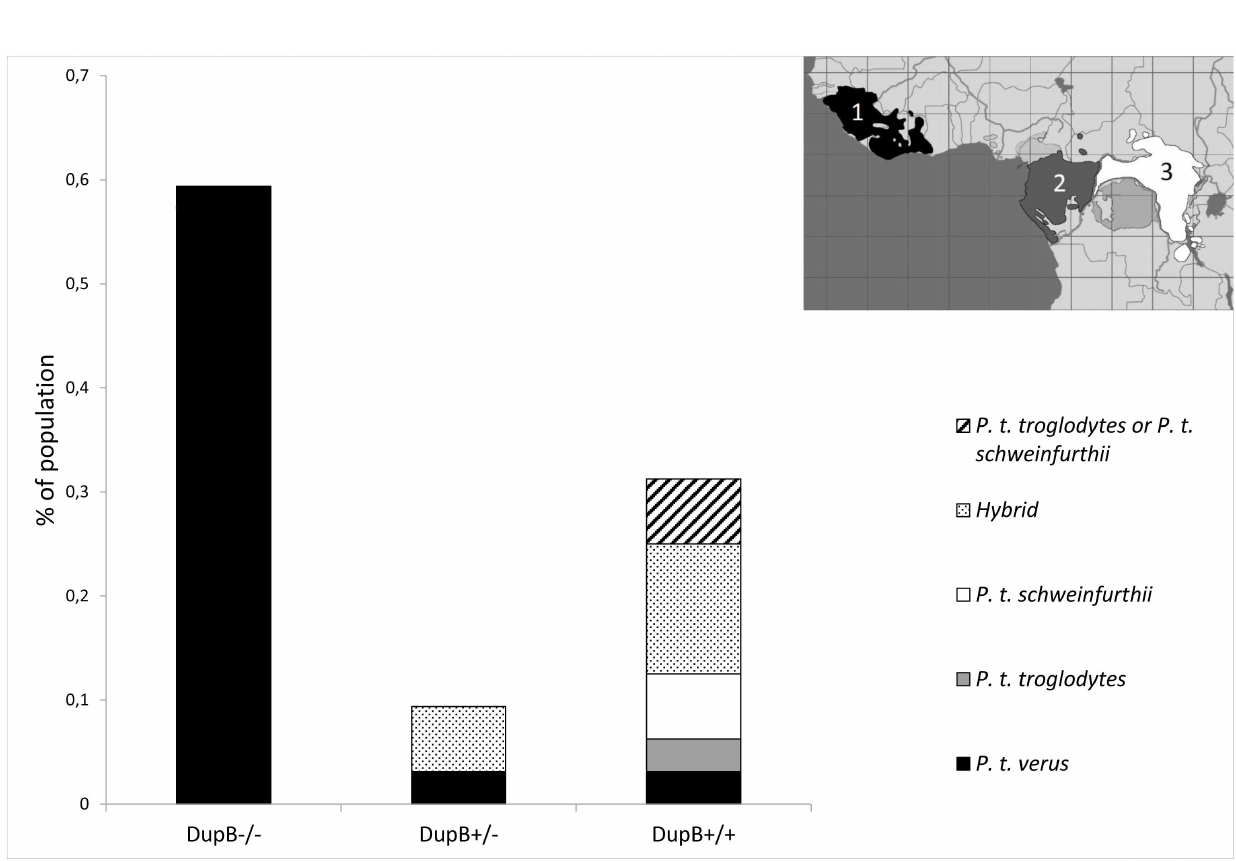
Figure 2. Distribution of DupB genotype frequencies for chimpanzee subspecies . X-axis shows individuals homozygous for the deletion (DupB 2 / 2 ), heterozygous for the deletion (DupB + / 2 ) or homozygous for the presence of RS3 (DupB + / + ). Different chimpanzee subspecies are indicated on the map in black (1) ( Pan troglodytes verus ), dark grey (2) ( Pan troglodytes troglodytes ) and white (3) ( Pan troglodytes schweinfurthii ). Hybrids are not shown on the map. (Map adapted from Pru¨fer et al 2012) [96].